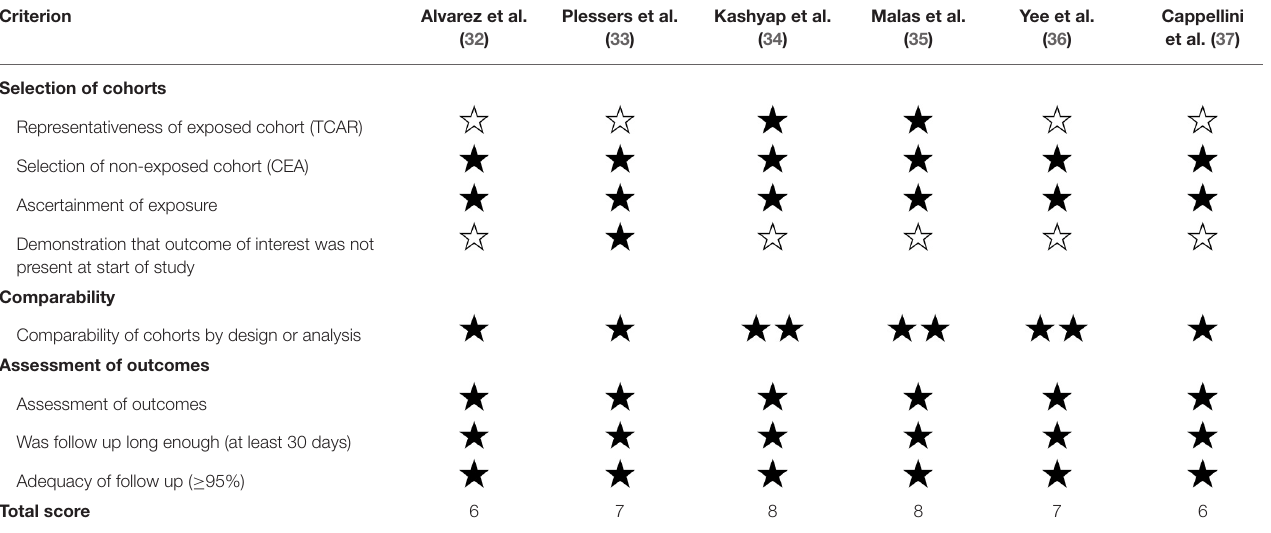
TABLE 3 | Quality assessment of comparative studies based on Newcastle-Ottawa Scale.